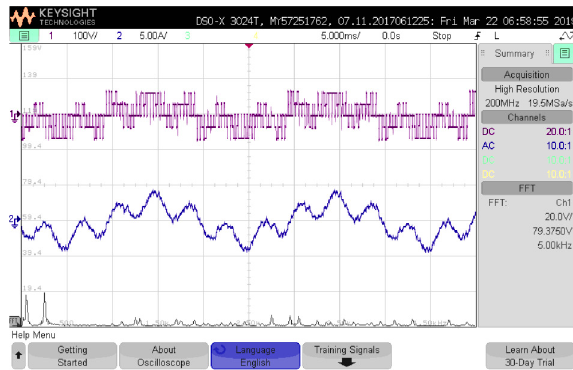
Figure 6. Time response of the voltage (upper graph) and current (middle waveform) of the phase a along with the voltage spectrum (bottom) for the reference voltage m 1 = m 2 =